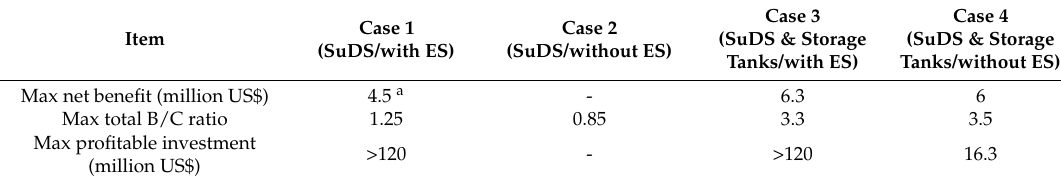
Figure 11. Pareto fronts for the four assessed cases/options. Table 2. Maximum net benefits and benefit–cost ratios for the assessed